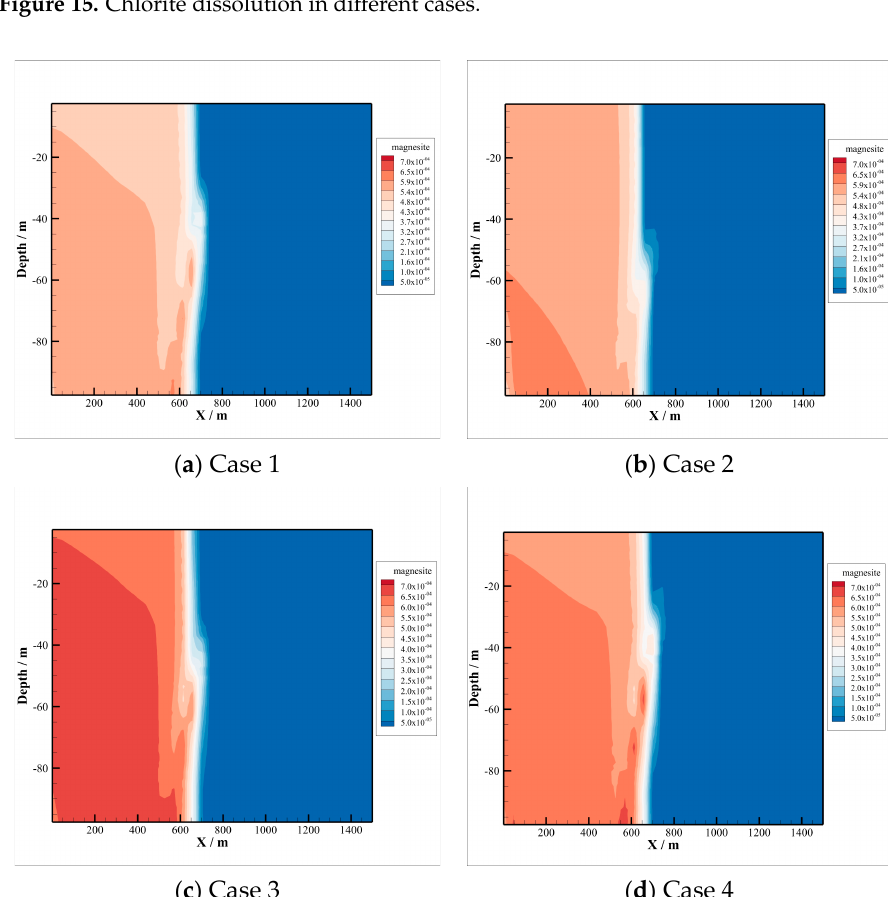
Figure 16. Magnesite precipitation in different cases.